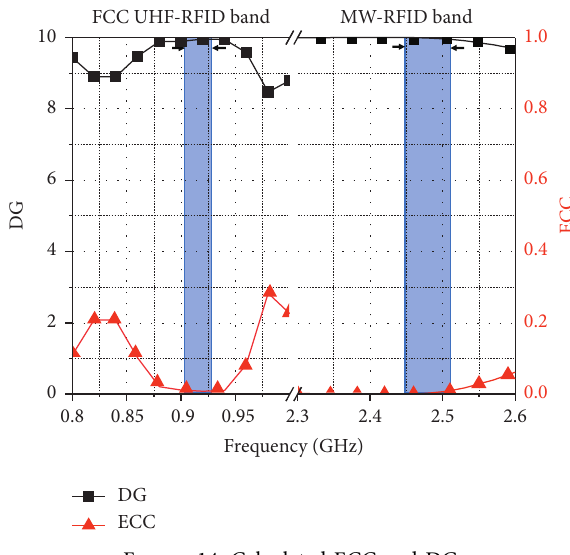
Figure 14: Calculated ECC and DG.